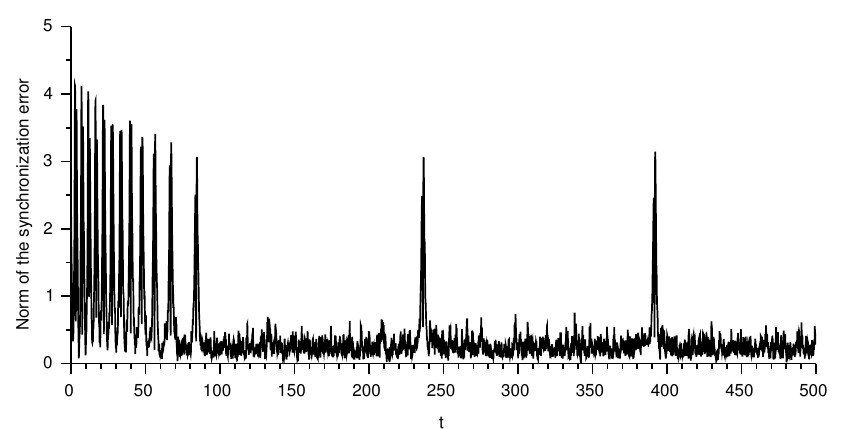
Figure 5. Norm of synchronization error in the membrane potential.